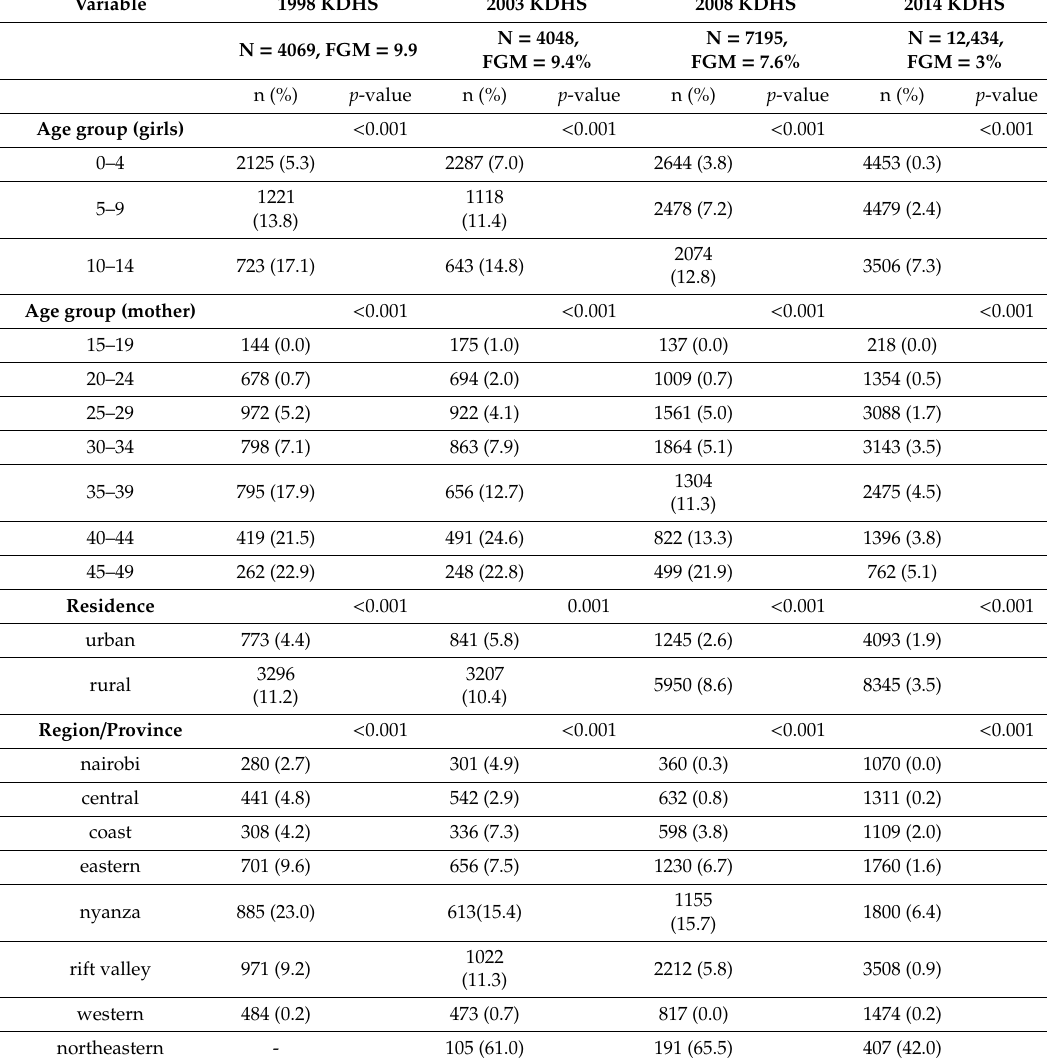
Table A1. Characteristics surrounding Female Genital Mutilation in Kenyan girls aged 0–14 yrs from 1998 to